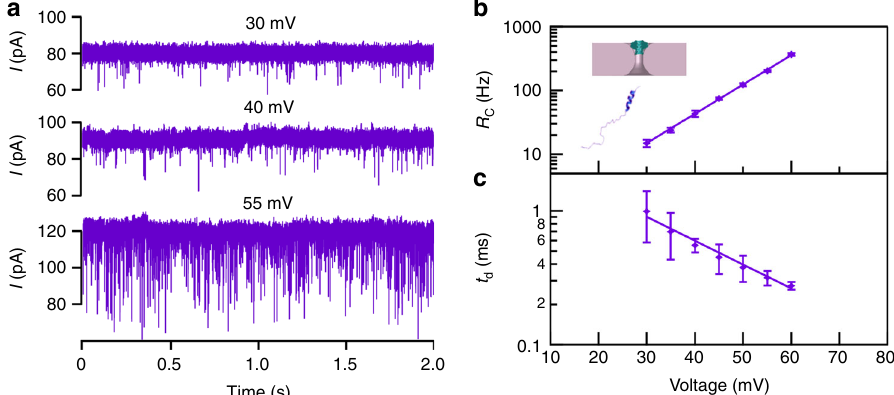
Fig. 3 Dynamics of TPX2 peptide transport. a Current vs time trace recorded through a hybrid pore at + 30, + 40 and + 55 mV in the presence of 10.3 μ M TPX2 peptide. b Semi-log plot of the event frequency as a function of the applied voltage. c Semi-log plot of the peptide dwell time as a function of the applied voltage. The lines in ( b , c ) are exponential fi ts to the data. Experiments were performed in 0.5 M NaCl, 20 mM Tris, pH 7.5. Data shown in semi-log plots are mean and s.d. of 23,516 events (total for all points) from one hybrid